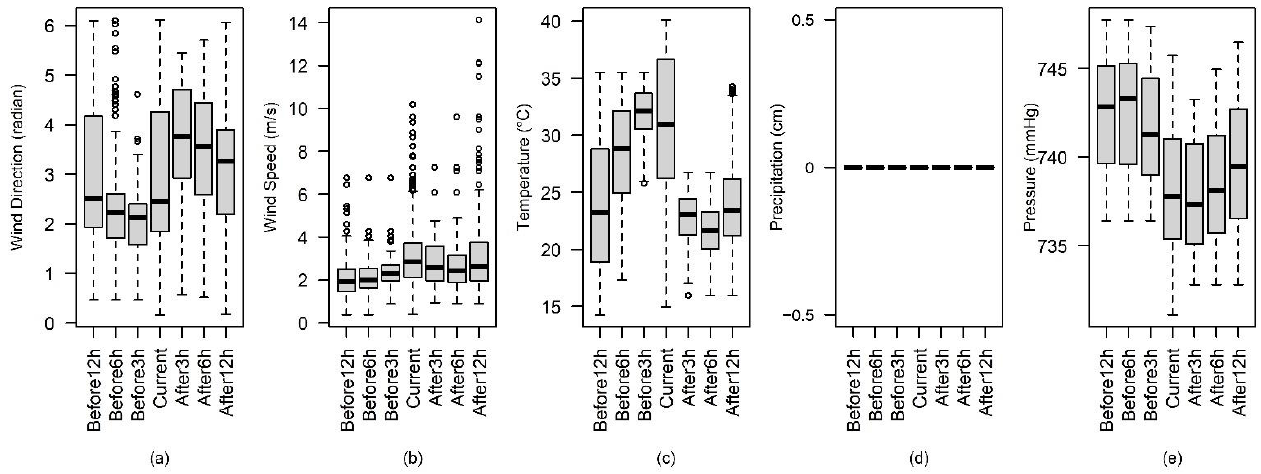
Figure 4. The box plots of ( a ) wind direction, ( b ) wind speed, ( c ) temperature, ( d ) precipitation, and ( e ) pressure using data 12-, 6-, and 3-h. before, during, and 3-, 6-, and 12-h. after the heatwave ex- treme